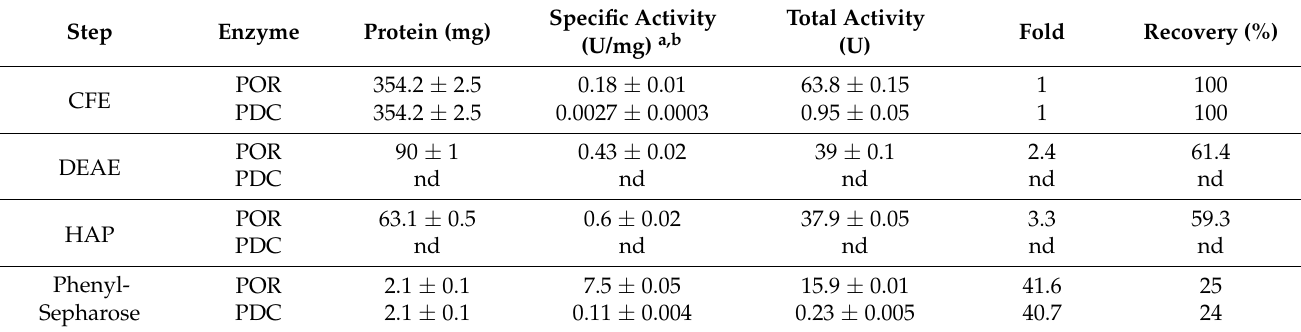
Table 1. Purification of the bifunctional POR/PDC from S. solfataricus